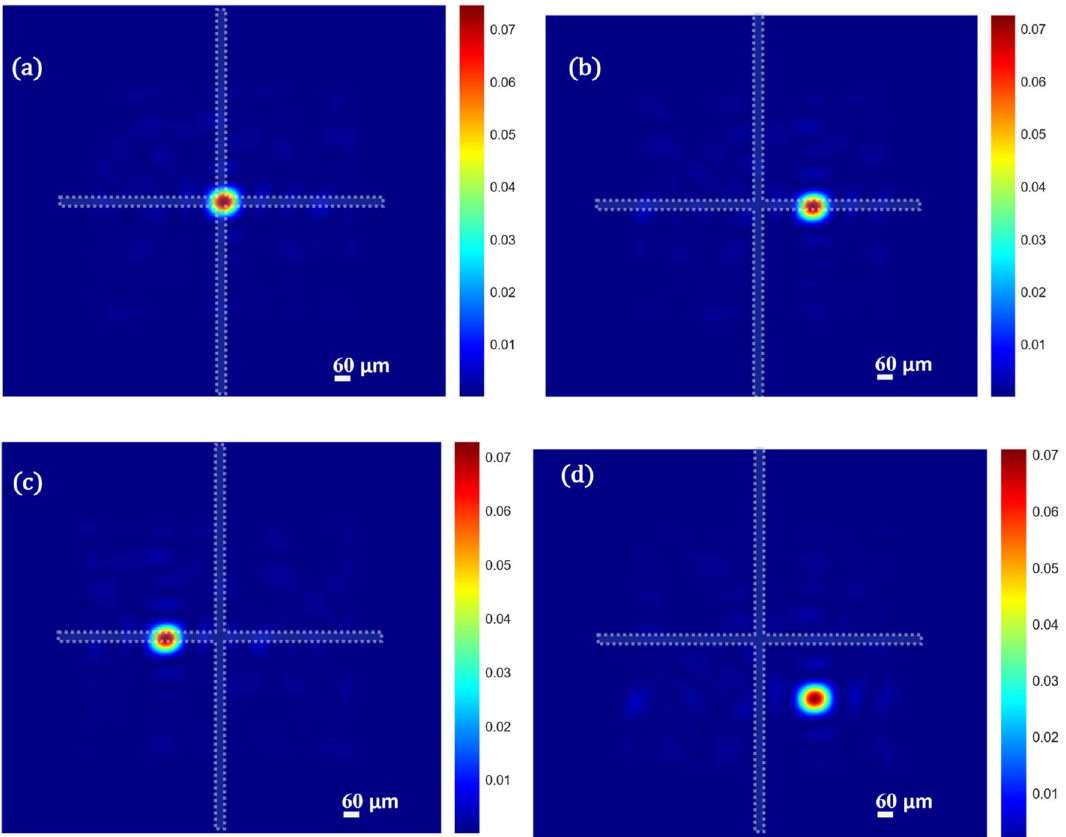
Figure 3. Simulation results for ( a ) focus obtained at the last diffuser plane ( b ) Shift in focus when the optimized mask is multiplied by a linear phase shift in positive x-direction, ( c ) Shift in focus when the optimized mask is multiplied by a linear phase shift in negative x-direction ( d ) Shift in focus when the optimized mask is multiplied by a linear phase shift both in x and y